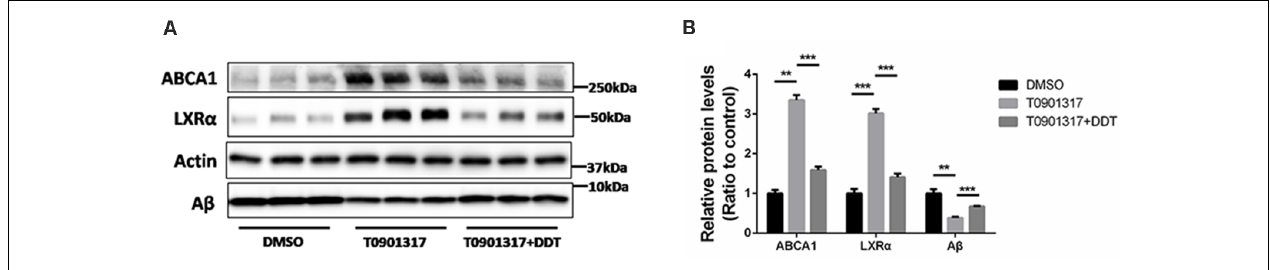
FIGURE 4 | LXR α agonist T0901317 upregulates LXR α protein levels and DDT antagonizes this autoregulation. (A) ATP-binding cassette transporter A1 (ABCA1) and LXR α protein expression in H4 human neuroglioma cells, as well as the remaining amyloid beta (A β ) in H4 human neuroglioma cells media. (B) Semiquantitative